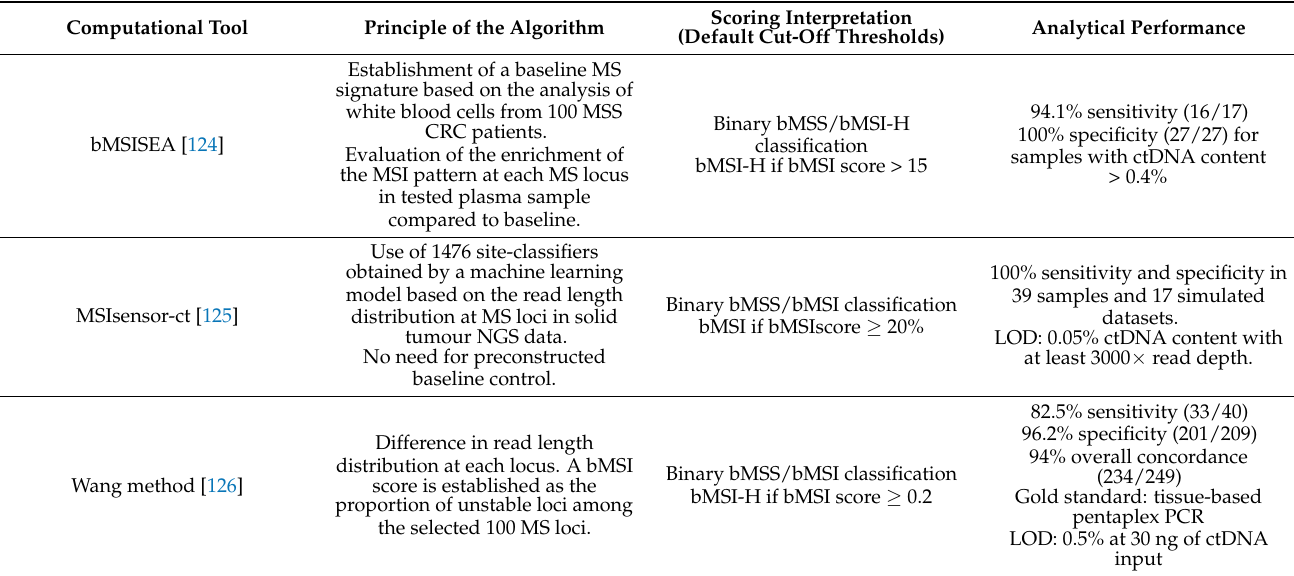
Table 5. Examples of NGS-based computational tools for bMSI